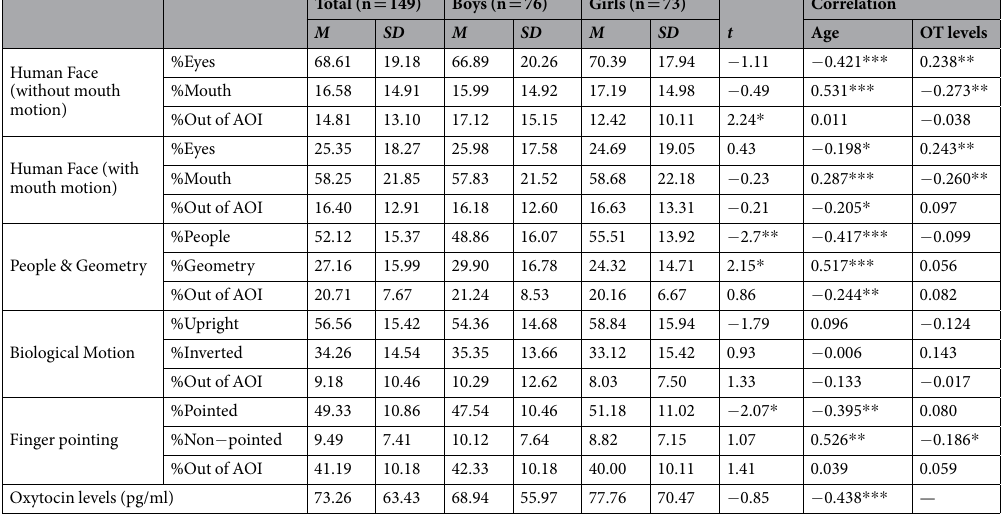
Table 1. Mean values and coefficients of salivary OT levels and gaze fixation parameters. * p < 0.05, ** p <